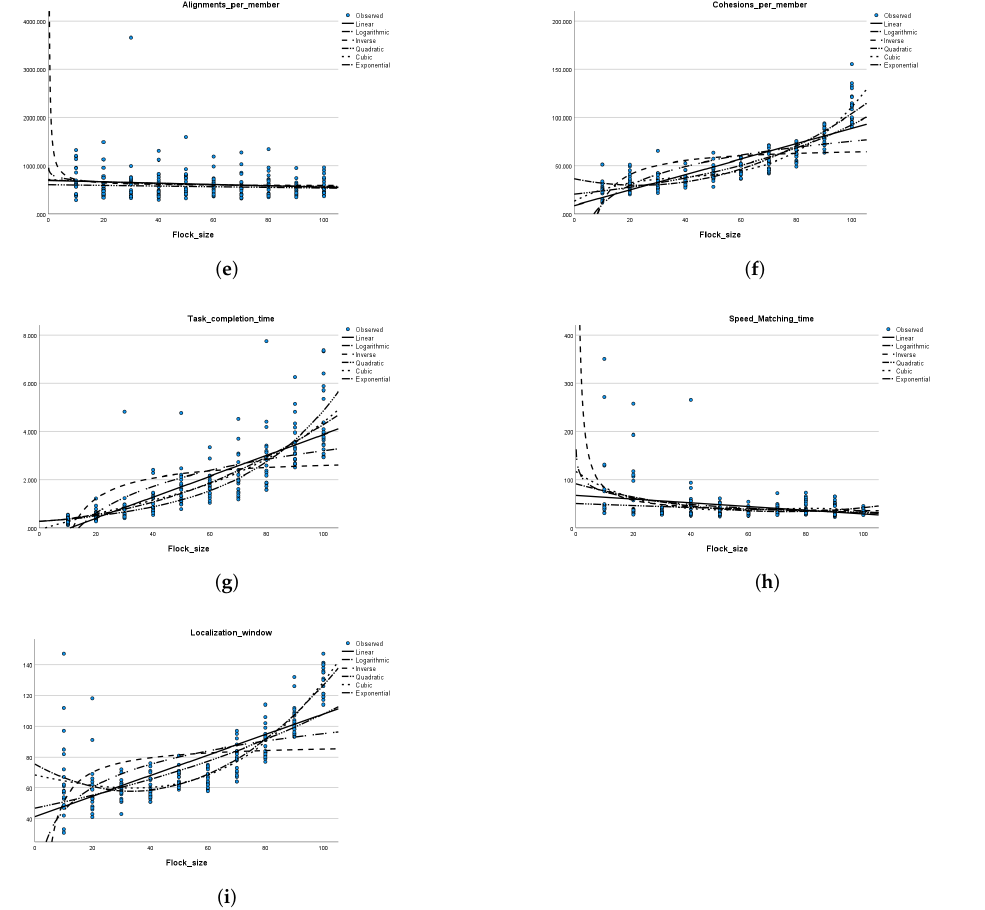
Figure 5. Relationship between the flock size and each of the performance metrics in an environment without obstacles. ( a ) Flock size versus the goal localization time. ( b ) Flock size versus the distance to the center of mass. ( c ) Flock size versus the average number of collisions per member. ( d ) Flock size versus the average number of applied separation rules per member. ( e ) Flock size versus the average number of applied alignment rules per member. ( f ) Flock size versus the average number of applied cohesion rules per member. ( g ) Flock size versus the average time of task completion. ( h ) Flock size versus the average speed matching time. ( i ) Flock size versus the average goal localization